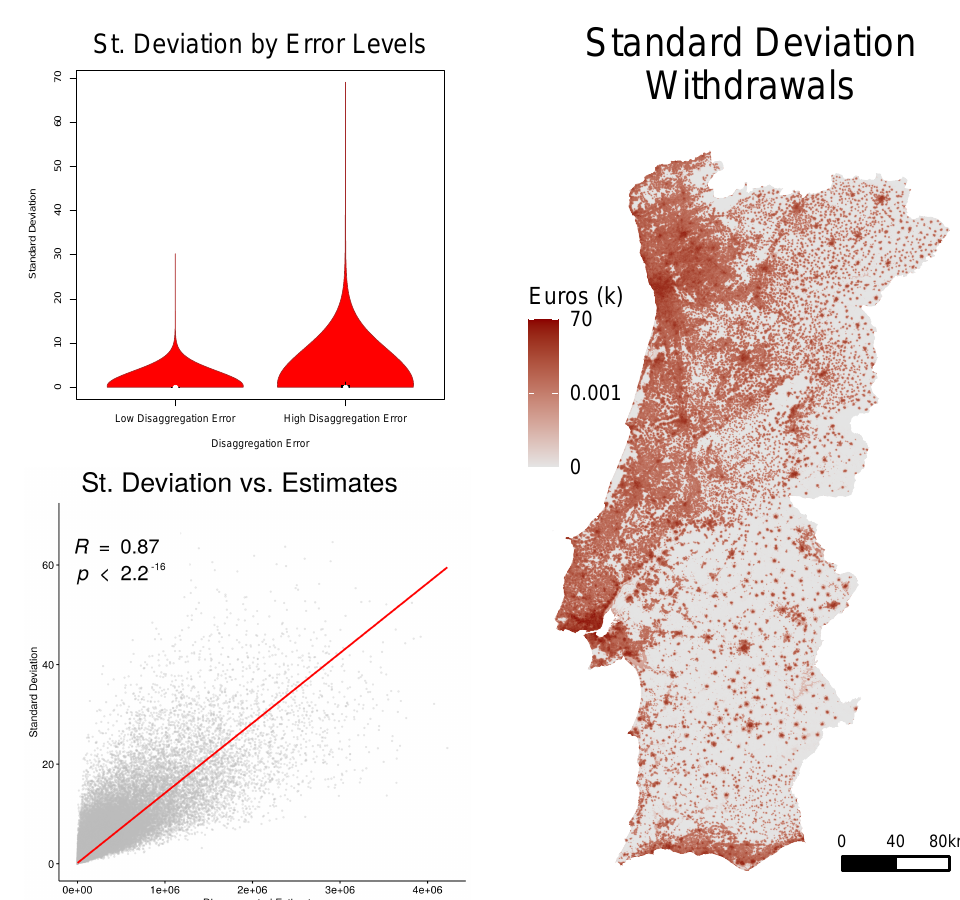
Figure 11. Standard deviation associated with the disaggregated raster cells for the variable corre- sponding to the overall number of national withdrawals.